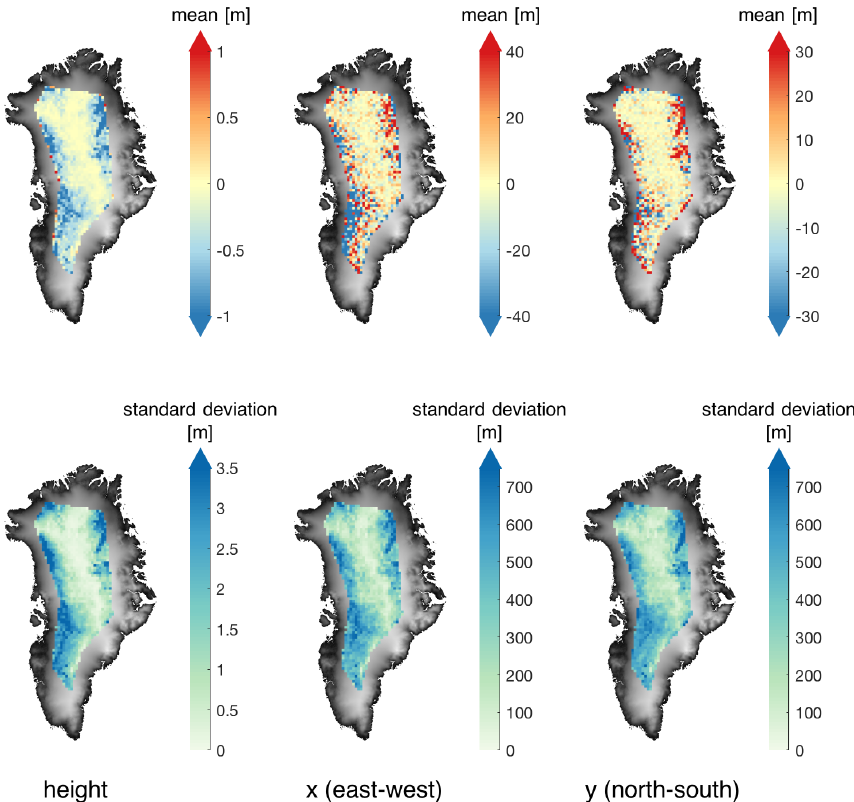
Figure C2. Mean and standard deviation of vertical and horizontal difference in derived impact point P l between (i) using the DEM with a homogeneous vertical displacement (cid:49)h DEM = 2 . 5m ( (cid:49)h DEM1 ) and (ii) using the original ArcticDEM (DEM orig ). The mapped locations are based on the horizontal locations ( x and y ) derived from DEM orig , tiled by the 25km × 25km grid as in Fig.